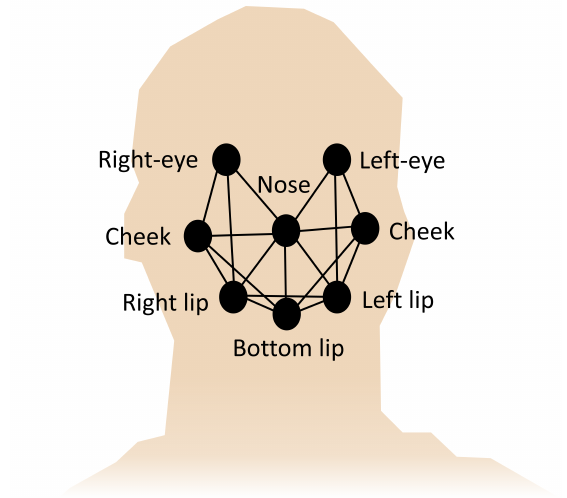
Figure 8. Example of landmarks extracted by Google’s Face API according to